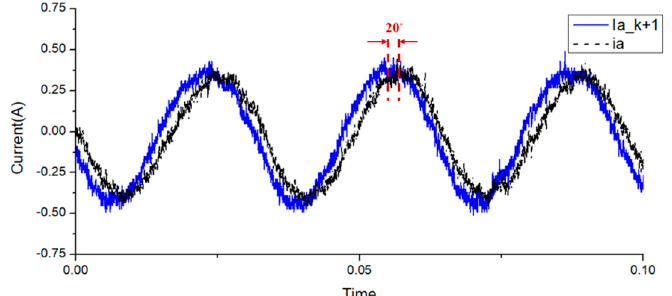
Figure 11. Modified MPCC current prediction analysis, where the solid line is the predicted A ‐ phase current, and the dotted line is the measured A ‐ phase current.